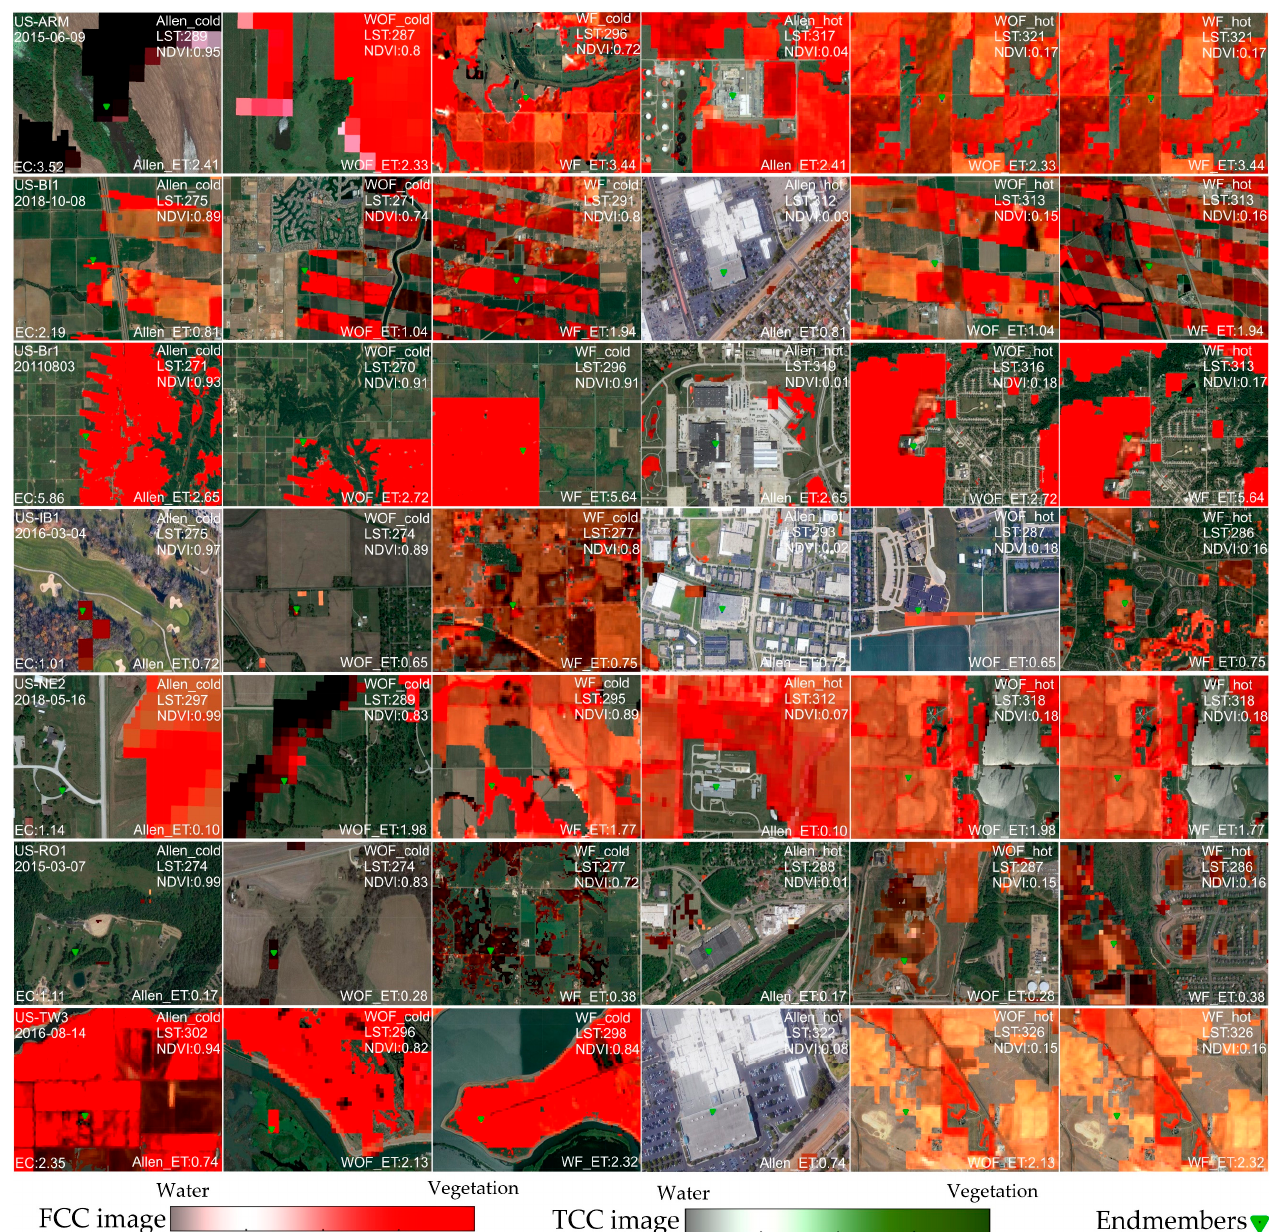
Figure 4. Cold and hot pixel locations and values alongside the statistics for one selected image of crop flux towers for different endmember selection methods using GLDAS meteorological data in SEBAL. The green triangles indicate endmember location on the intended land cover extracted from the FCC image, and over the background of Google Earth images. Each scenario’s ET estimation performance is coded as Allen_ET, WOF_ET, and